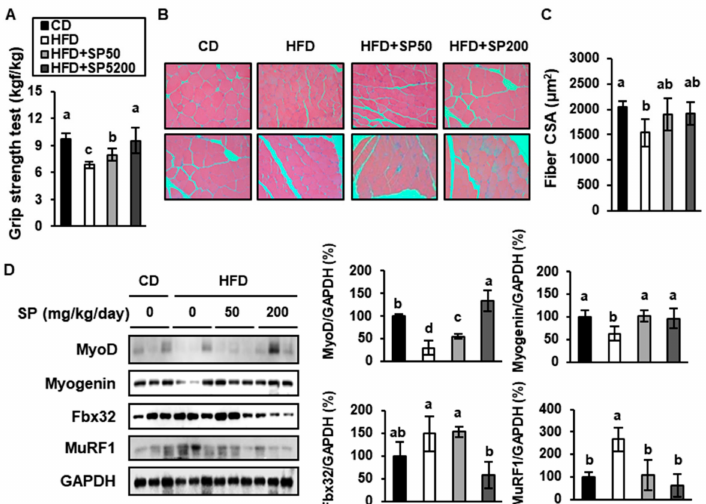
Figure 6. Effect of silk peptide on proteins mediating muscle differentiation and sarcopenia in HFD-fed mice. ( A ) Grip strength was measured after 6 weeks of treatment. ( B ) Hematoxylin and eosin